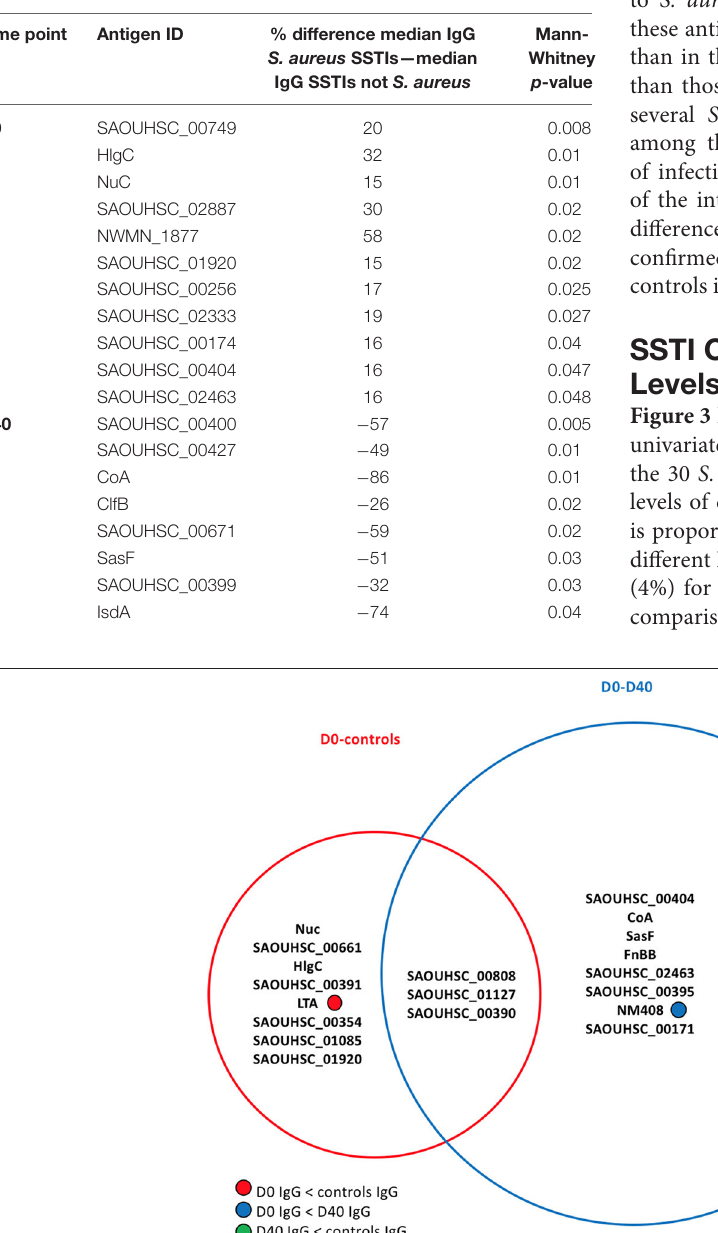
TABLE 3 | Percent differences between the median IgG levels among case subjects with culture-confirmed S. aureus SSTIs and those with SSTIs not confirmed to be due to S. aureus for the antigens with Mann-Whitney p -value < 0.05.